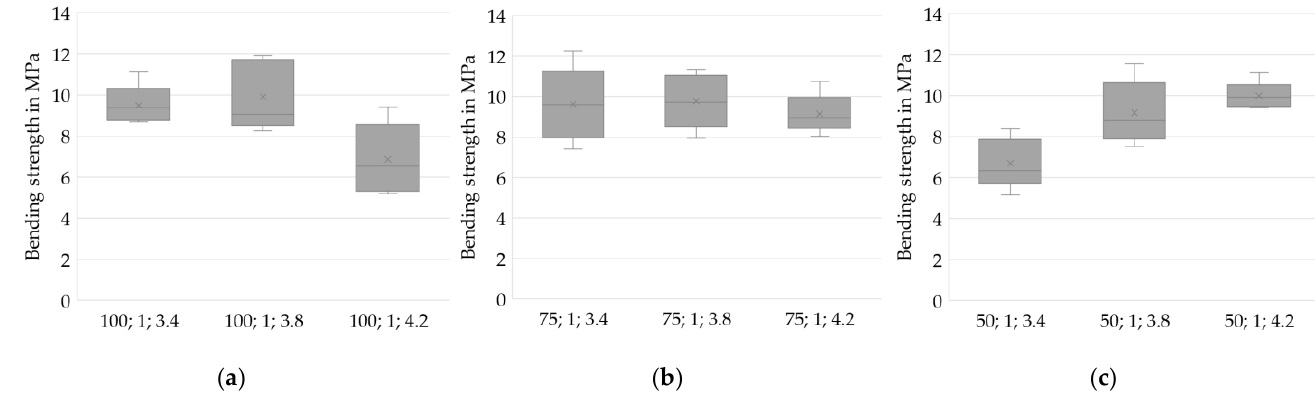
Figure 10. Four-point bending strengths for various layer heights. Higher drying intensities result in reduced strengths for h = 100 µm ( a ) and in increased strengths for h = 50 µm ( c ). For h = 75 µm, no trend can be deduced ( b ). ( a ) h = 100 µm, n = 5; ( b ) h = 75 µm, n = 5; ( c ) h = 50 µm, n = 5.